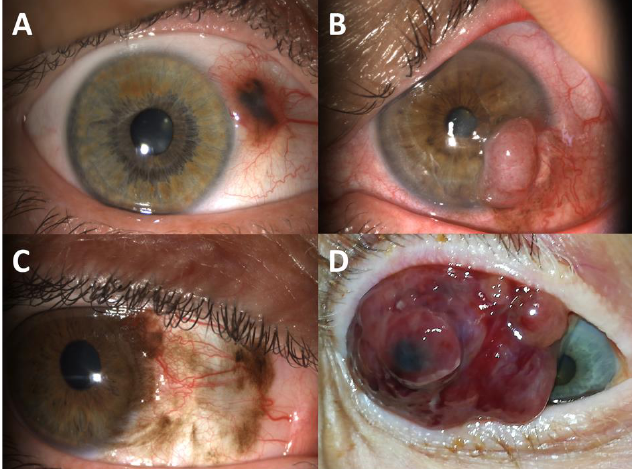
Figure 1. Clinical aspect of conjunctival melanoma (CM) upon presentation or after recurrence: ( A ) CM arising from a naevus; ( B ) Recurrence of achromic CM with primary acquired melanosis (PAM) (first surgery performed in another area without “no-touch” surgery); ( C ) Extended multifocal CM arising from PAM; ( D ) Early and massive recurrence of CM despite wide local excision followed by proton beam radiotherapy. The patient underwent orbital exenteration and died from metastatic spread of his CM